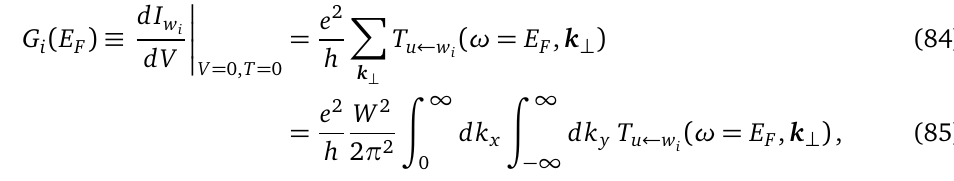
and the slope of the tilt profile F ) as detailed in App. B. Here, the solid blue F π b α , respectively, with 2